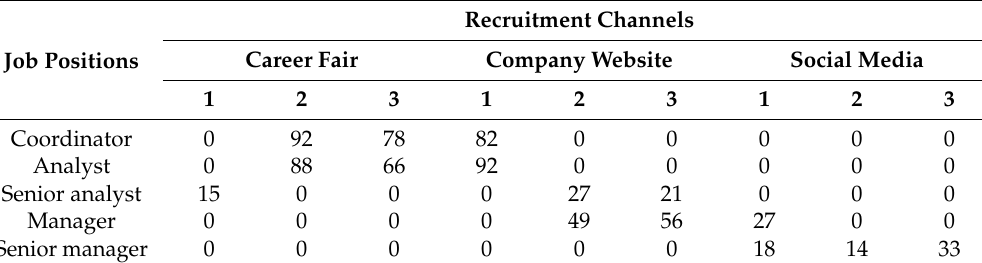
in three time periods. ij